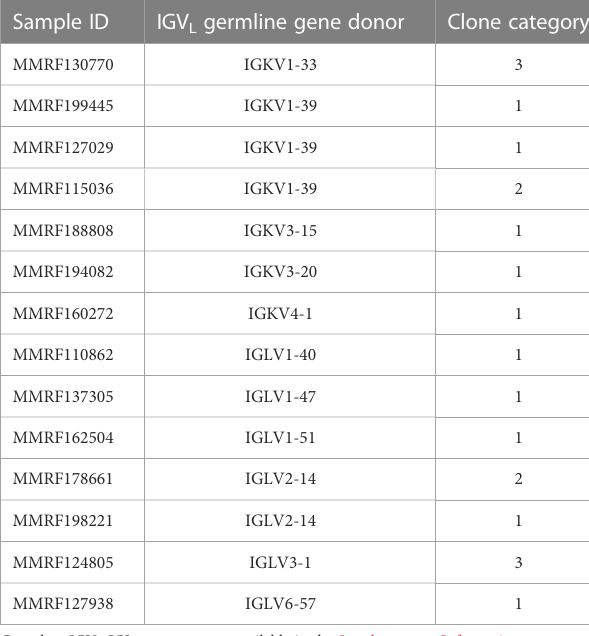
TABLE 2 The IGV L germline gene usage and clone category in MM cases with AL amyloidosis. Sample